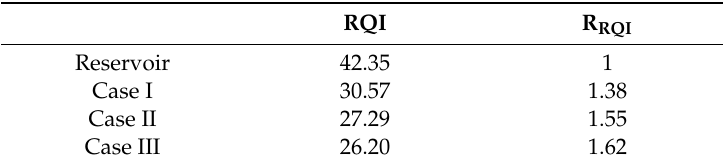
Table 5. Calculated rock quality index ratio for all three